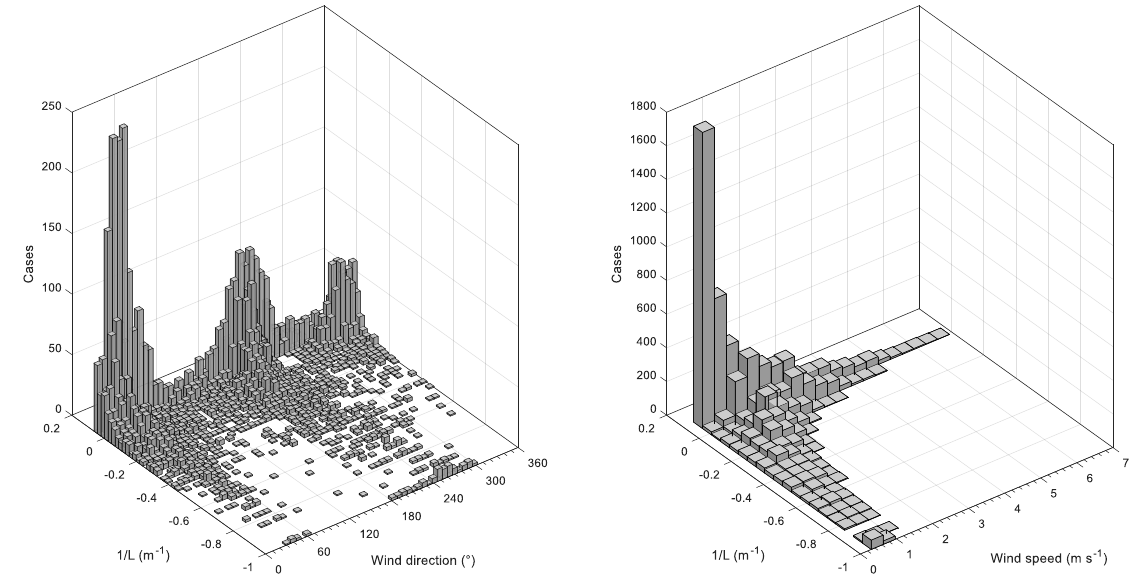
Figure 5. Bivariate histogram plots comparing the atmospheric stability estimated by the AERMOD model (in terms of 1 / L ) against wind direction ( left ) and wind speed ( right ).